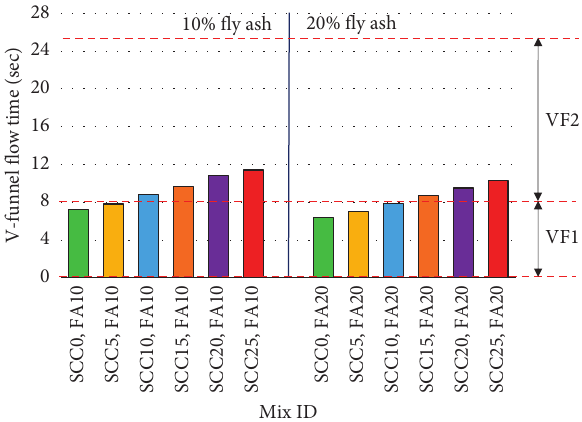
Figure 3: V-funnel test values for the fresh